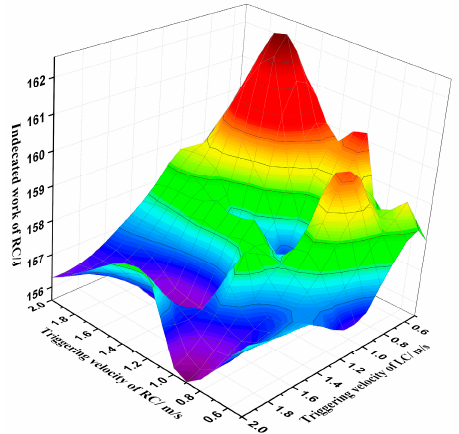
Figure 16. Indicated work contour map of the RC for different values of the “triggering velocity” (experiment).